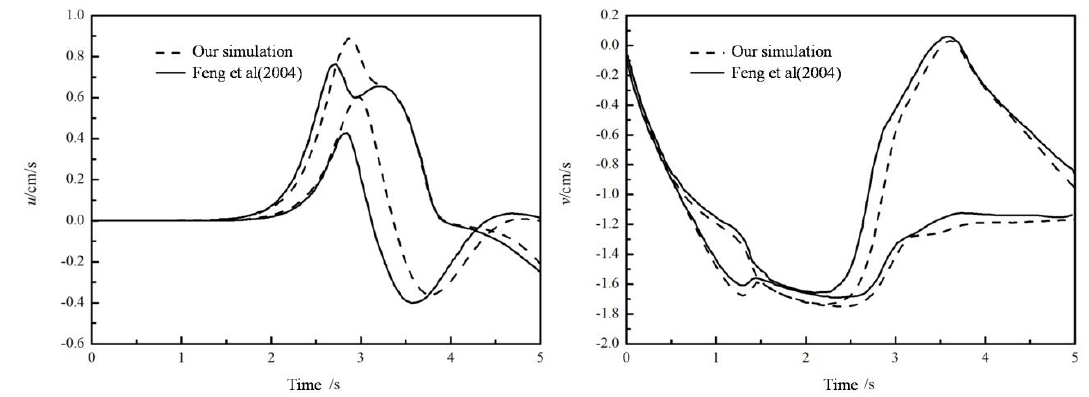
Figure 3. Velocities of the two particles (left: x direction; right: y direction).